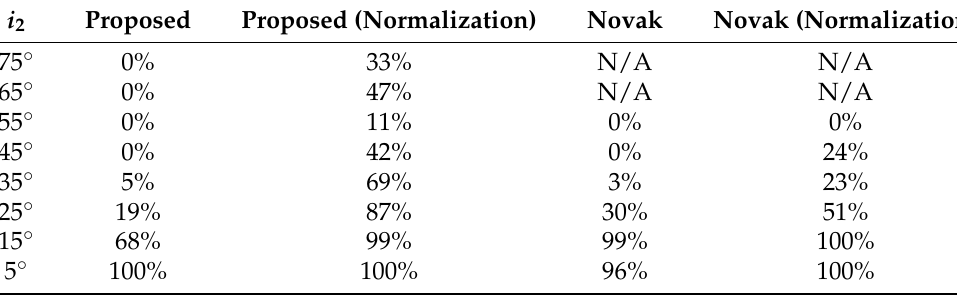
Table 8. POC of different methods with different i 2